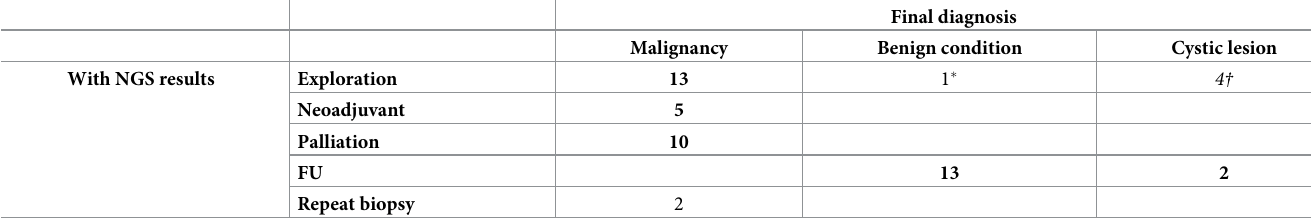
Table 4. Treatment plan after NGS integration compared to final